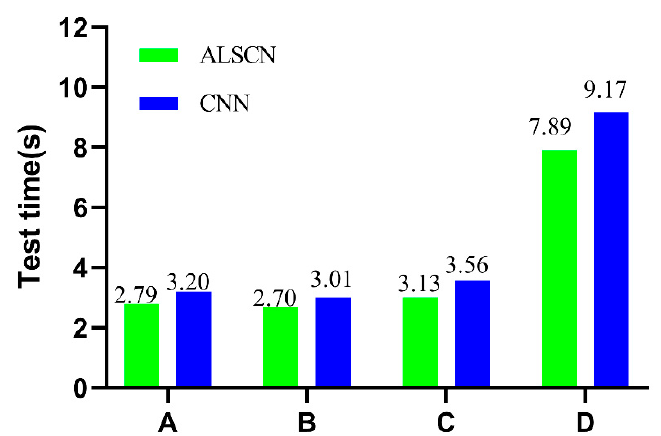
Figure 11. Comparison of test consuming between ALSCN and CNN.